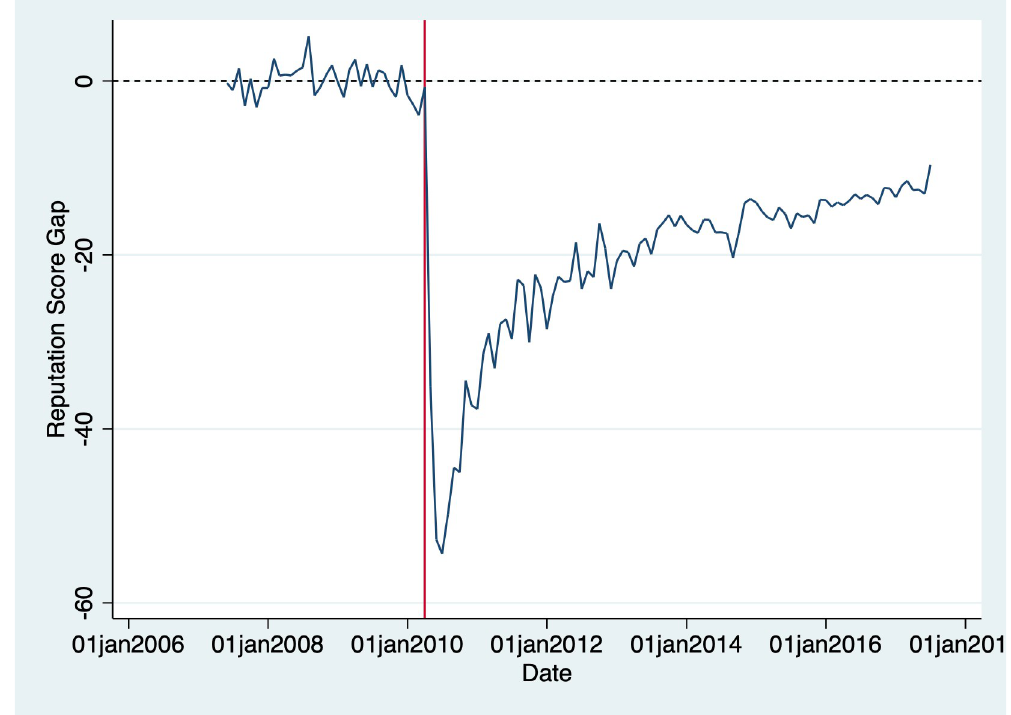
Fig 2. Gap between BP and synthetic control